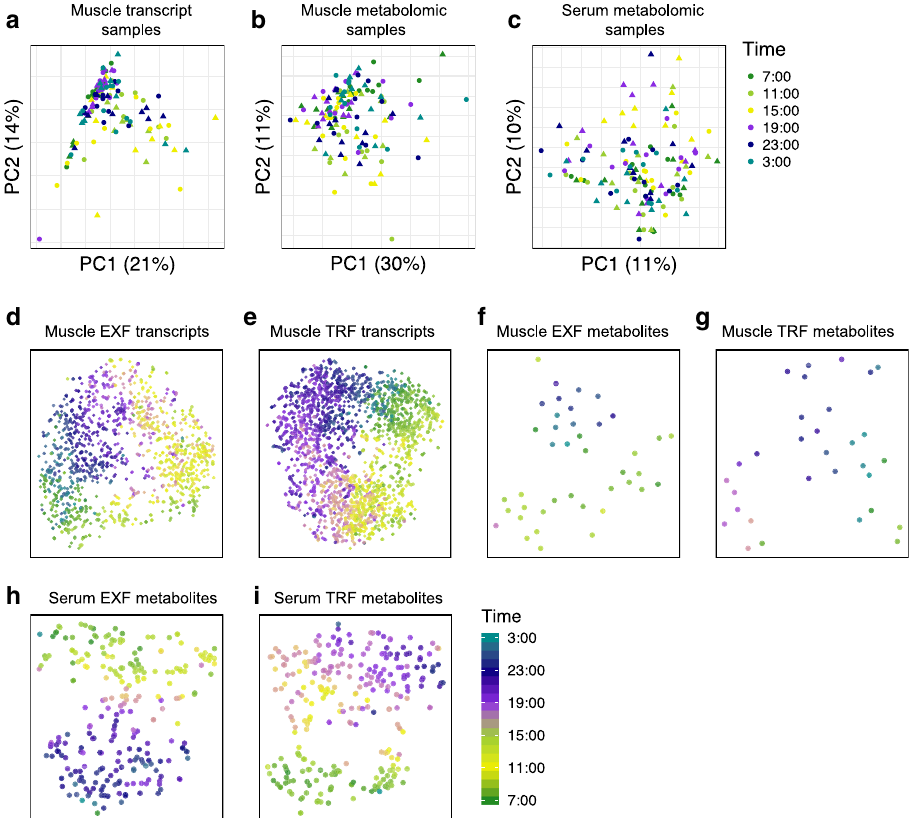
Fig. 1 Dimensionality reduction of samples and periodic features. Principal component analysis (PCA) of samples based on skeletal muscle genes ( a ), skeletal muscle metabolites ( b ), and serum metabolites ( c ), with color indicating sampling time. Circle indicates extended feeding (EXF), and triangle indicates time-restricted feeding (TRF). t-SNE clustering of periodic transcripts in skeletal muscle after EXF ( d ), and TRF ( e ). Periodic metabolites in skeletal muscle after EXF ( f ), and TRF ( g ), and serum metabolites after EXF ( h ), and TRF ( i ). n = 11